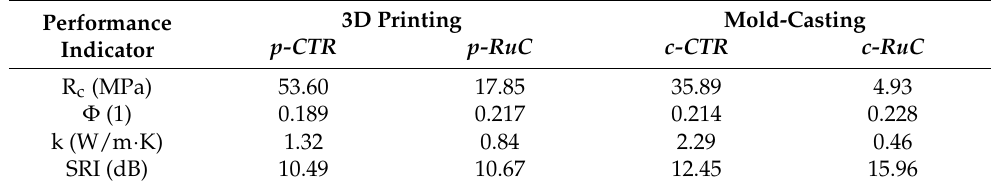
Table 1. Performance indicators of 3D-printed and mold-casted